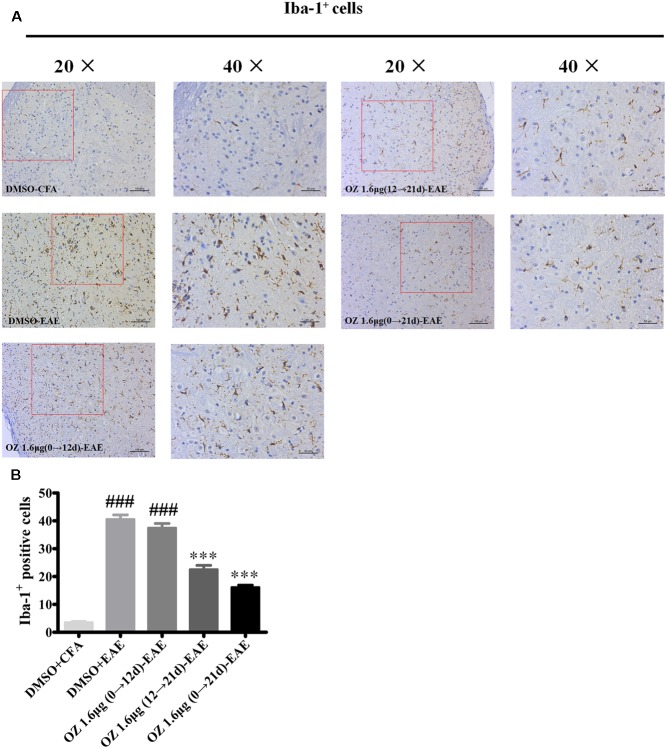
The effect of 5Z-7-oxozeaenol treatment on Iba-1-positive microglia in the spinal cords of EAE mice. Immunohistochemistry was used to evaluate the Iba-1-positive microglia in the lumbar intumescence spinal cord in each group. Counts of Iba-1-positive microglia were determined by quantitative method. Five fields from each mouse were analyzed. (A) Representative immunohistochemistry of Iba-1-positive microglia. (B) Quantification of Iba-1-positive microglia in the spinal cord. Each group included five mice, except for the 5Z-7-oxozeaenol 1.6 μg (0→12 d)-EAE group, which only had four mice because one died. ∗∗∗P < 0.001 versus DMSO-EAE group, ###P < 0.001 versus DMSO-CFA group (one-way ANOVA). Data are means ± SEM. OZ, 5Z-7-oxozeaenol. Scale bar = 50 μm for 20×, 100 μm for 40×.